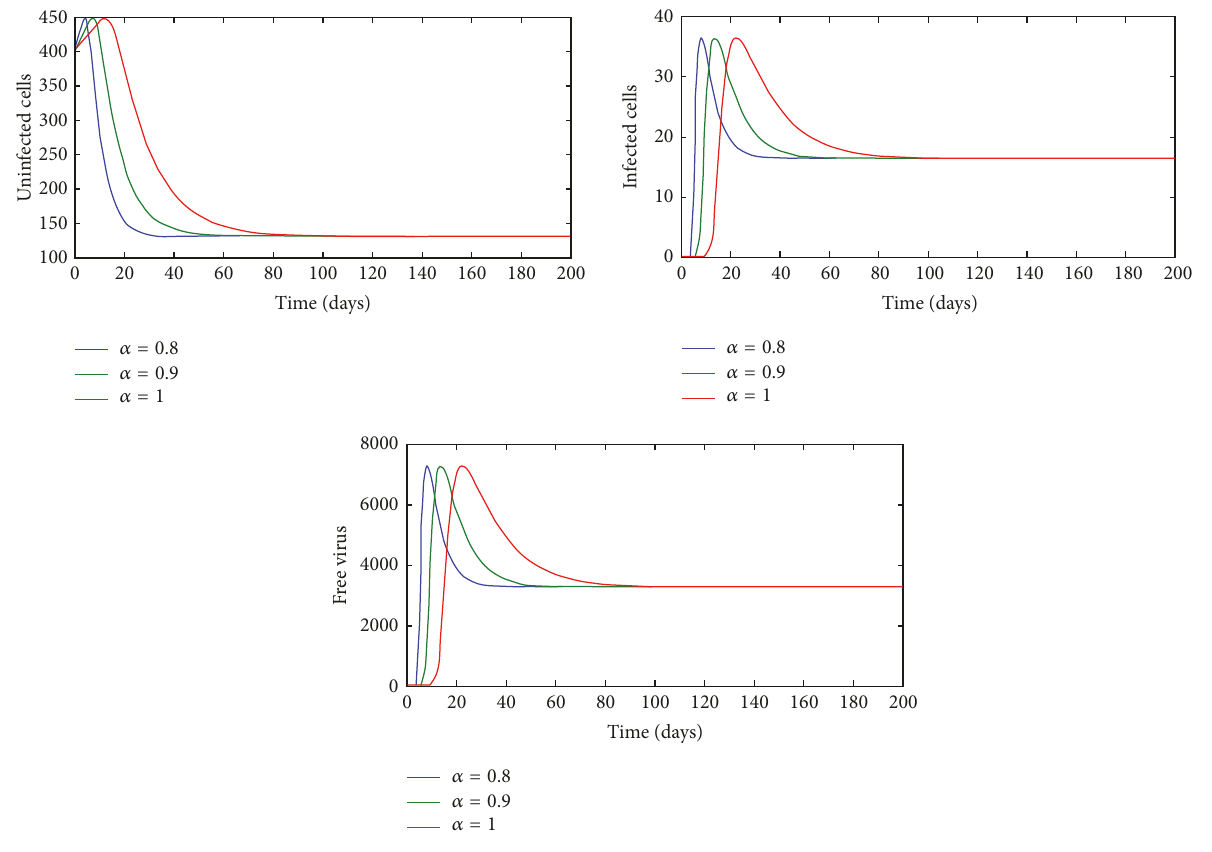
Figure 2: Stability of the chronic infection equilibrium 𝐸 1 .